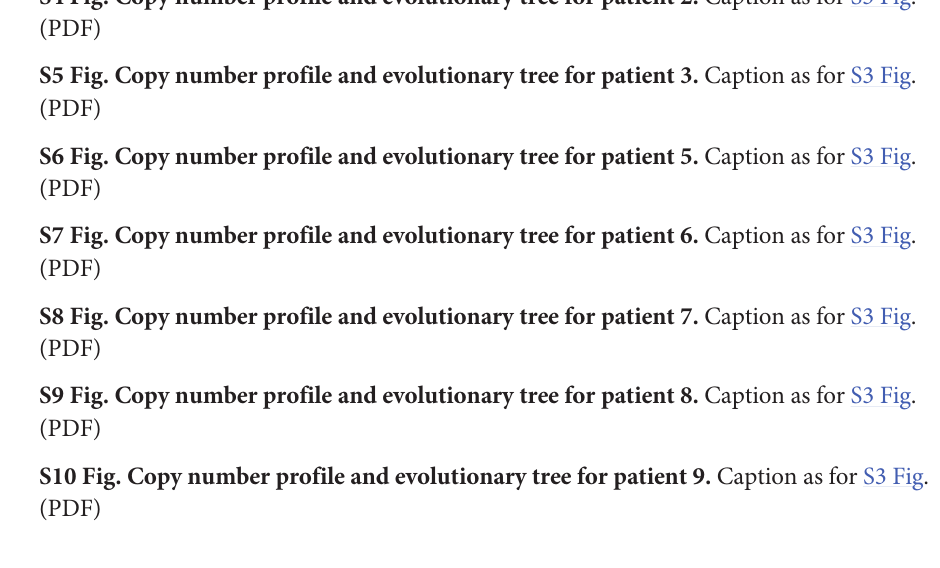
S3 Fig. Copy number profile and evolutionary tree for patient 1. Only selected copy number profiles are shown (A); these are marked in bold in the evolutionary tree (B). Individual alleles are coloured in red and blue. Confidence values for each split in the tree are given in red boxes. The colour bars to the right of the tree indicate different sampling sites (left) and sampling times (right). Branch lengths are given in number of rearrangement events. Particularly long branches are marked in